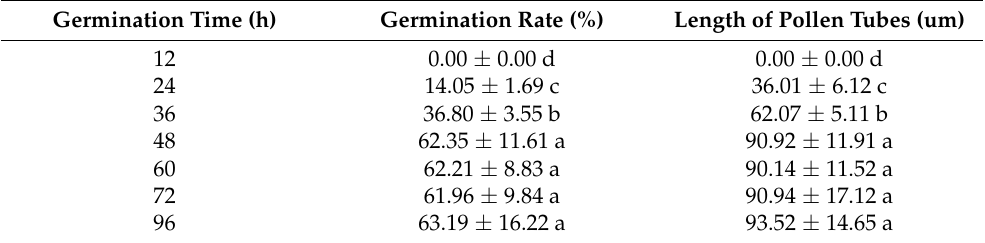
Table 5. Variation of pollen germination of T. distichum var. distichum with a change in culture time.